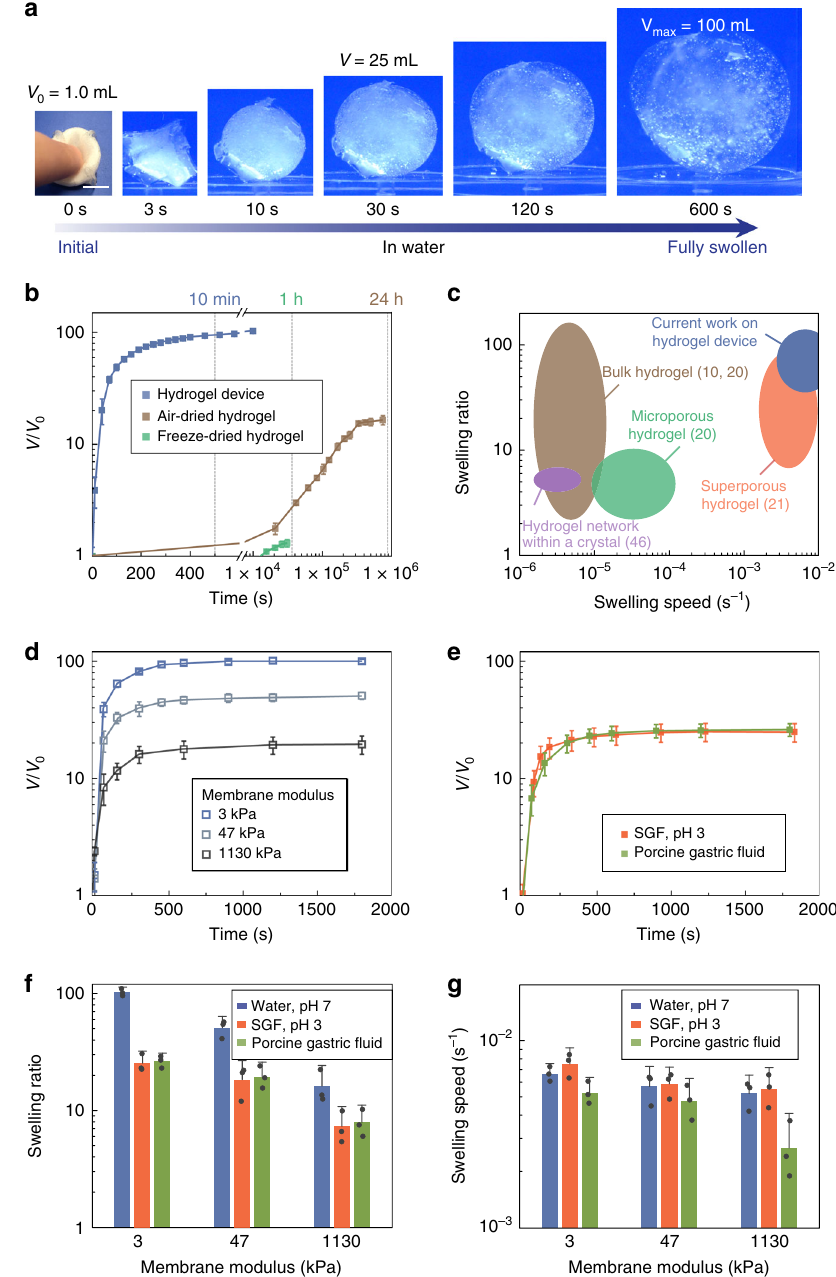
Fig. 2 High-speed and high-ratio swelling of the ingestible hydrogel device. a Time-lapse images of the hydrogel device swelling in water (pH 7). b Volume changes of the hydrogel device (membrane modulus 3 kPa), air-dried hydrogel, and freeze-dried hydrogel of the same size as a function of swelling time in water. c Comparison of the swelling ratios and speeds in water between the hydrogel device in current work and previously reported hydrogels 10,20,21,46 . d Volume changes of the hydrogel devices with various membrane moduli as functions of swelling time in water. e Volume changes of the hydrogel devices (membrane modulus 3 kPa) as functions of swelling time in porcine gastric fl uid and SGF (pH 3). f Swelling ratios of the hydrogel devices with various membrane moduli in water, SGF (pH 3), and porcine gastric fl uid. g Swelling speeds of the hydrogel devices with various membrane moduli in water, SGF (pH 3), and porcine gastric fl uid. Scale bars are 10 mm in ( a ). Data represent the mean ± s.d. ( N =